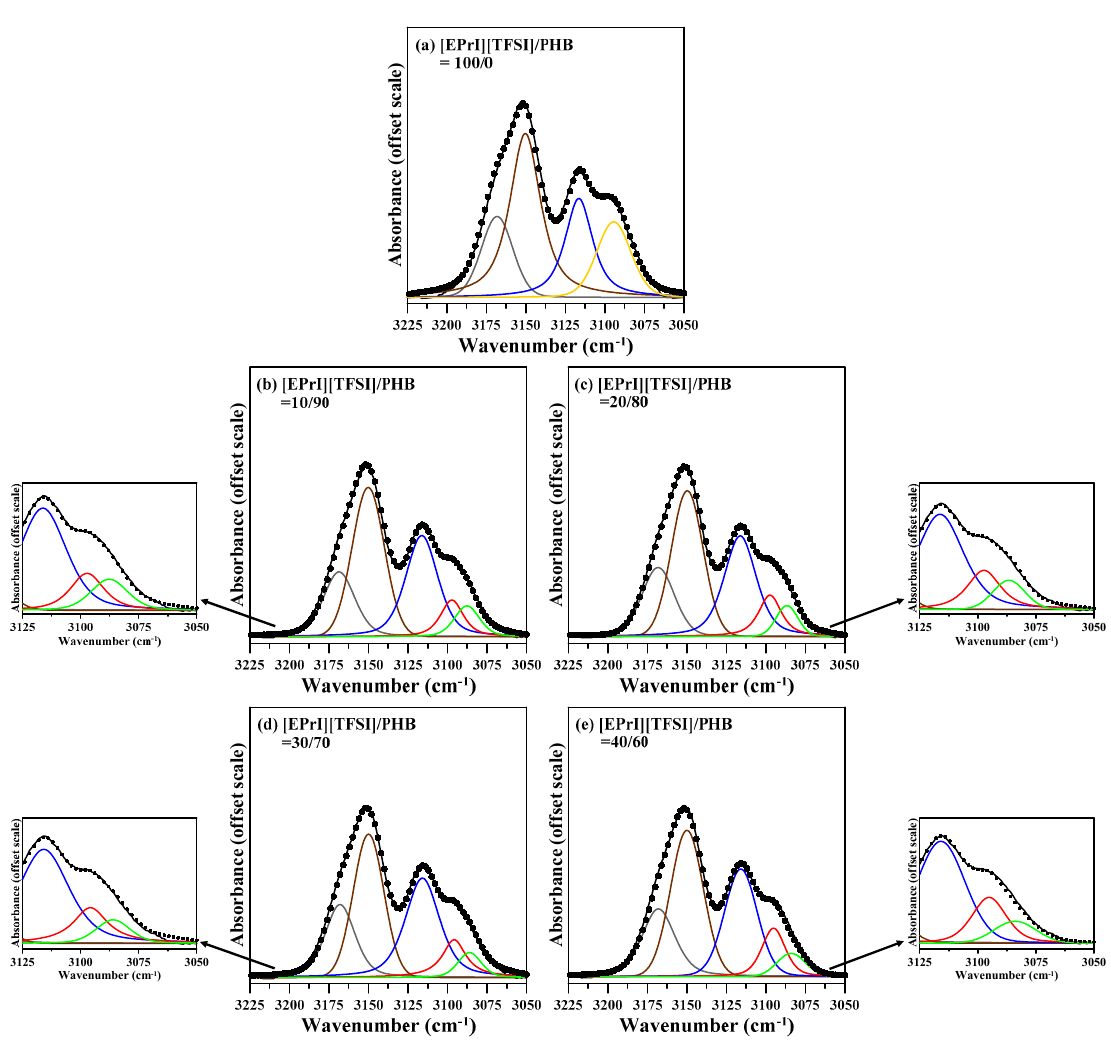
Figure 11. Deconvoluted FTIR spectra in the C–H stretching vibrational region of imidazolium cation ring for [EPrI][TFSI]/PHB blends with different compositions: ( a ) 100/0; ( b ) 10/90; ( c ) 20/80; ( d ) 30/70; and ( e ) 40/60.